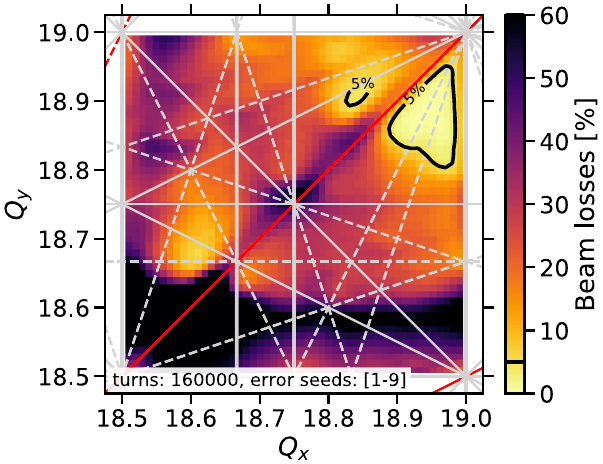
FIG. 17. Double-harmonic rf operation. Beam-loss tune dia- gram after the injection plateau obtained from the FFSC simu- lations with the full field error